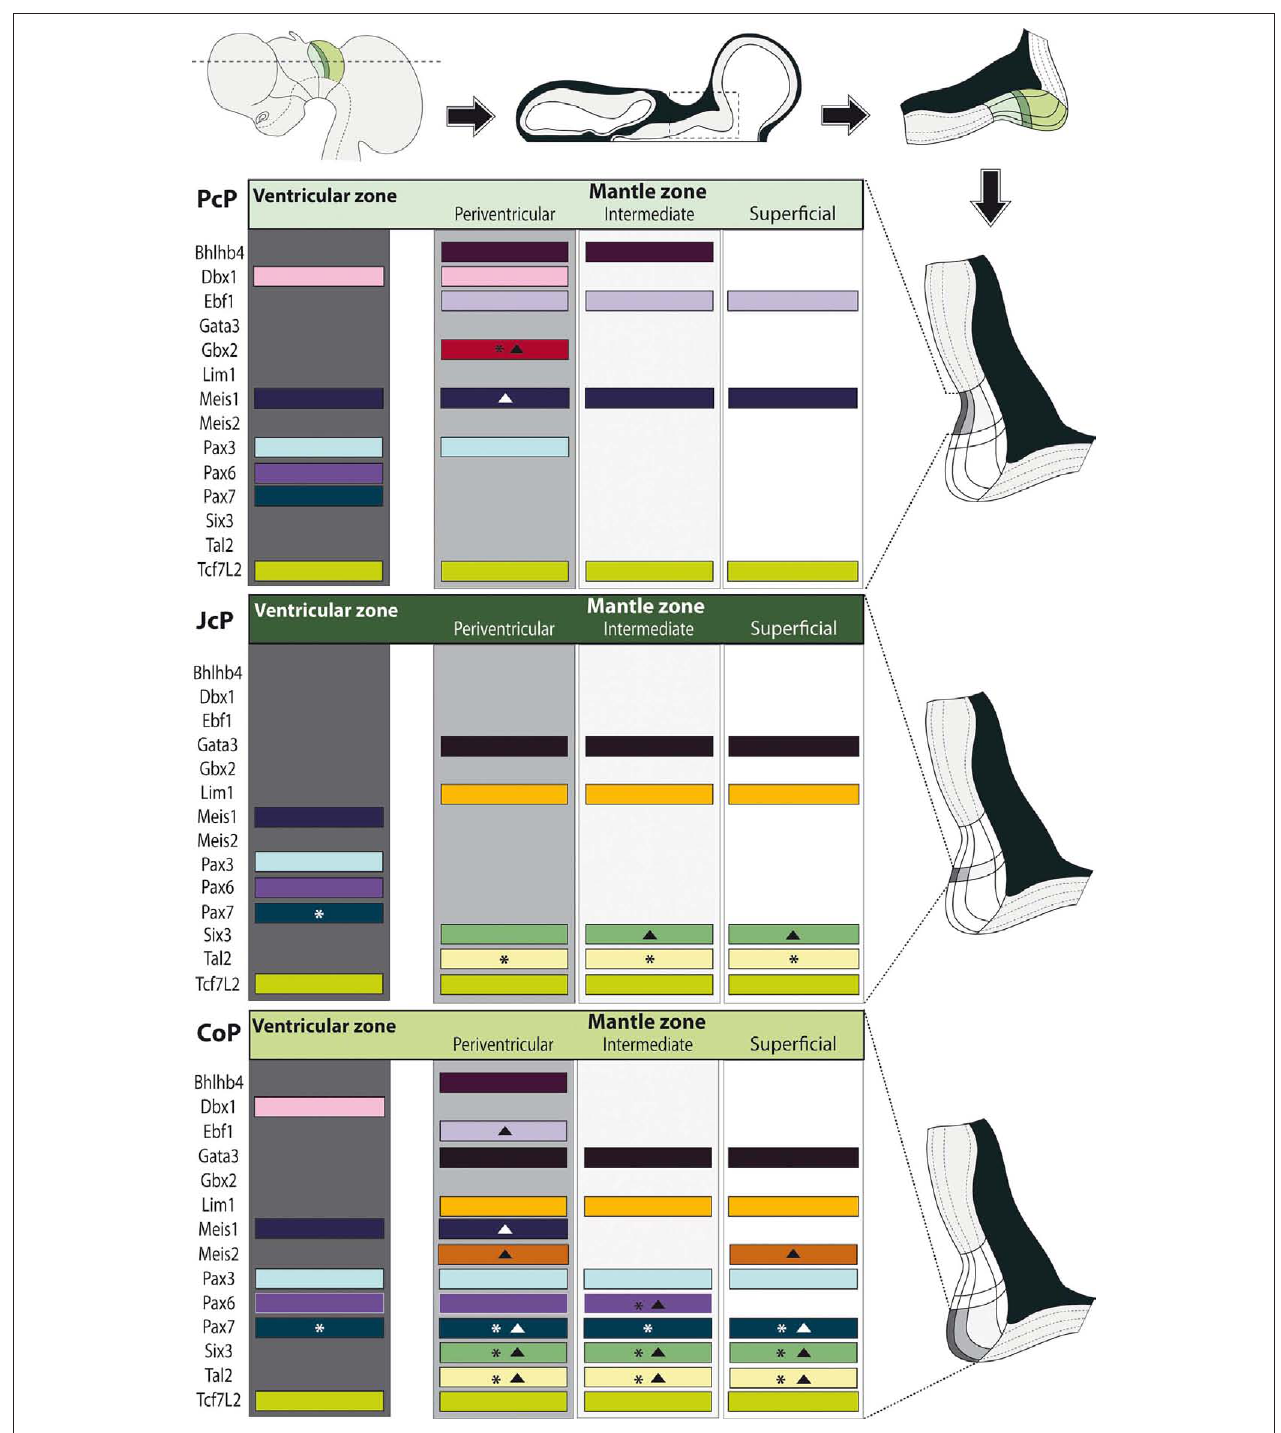
specific domain whose molecular profile per strata is shown at left ( Dark gray : ventricular zone; light g ray : periventricular stratum). Schematics at the left side: Each block represents an entire domain (PcP, JcP, CoP), where the expression of the listed genes – represented by a colored bar – is attributed to the relevant strata. The asterisks imply that this gene is not expressed throughout the dorsoventral extent of the stratum. Solid triangles imply that some cells in the stratum downregulate this mRNA